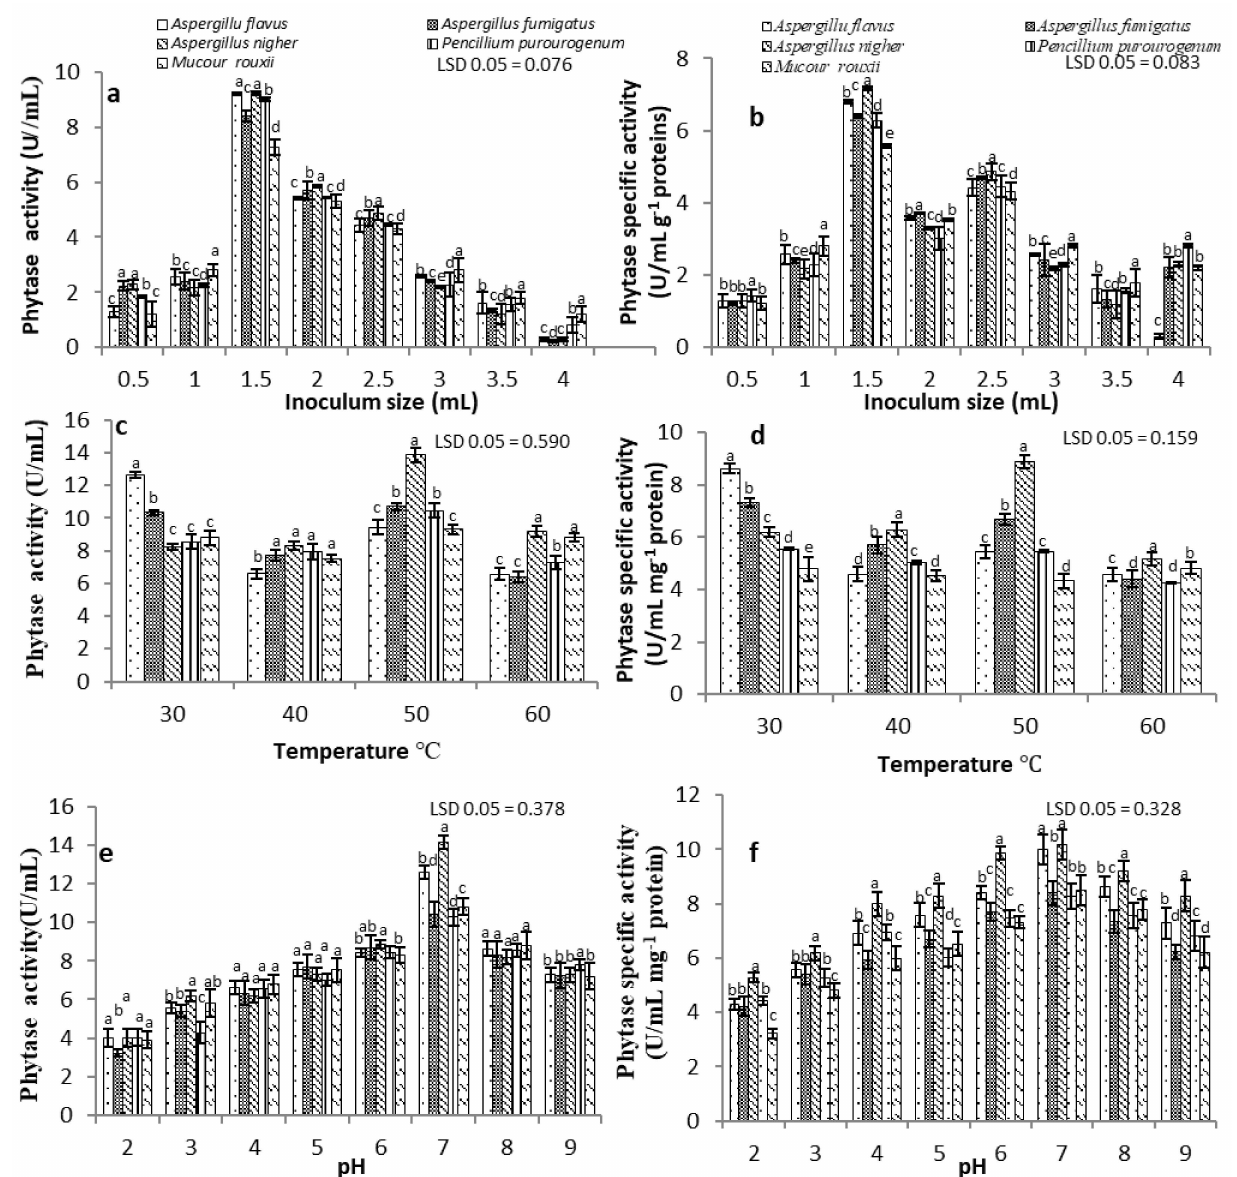
Figure 3. Effect of various eco-cultural conditions (inoculum size, temperature, and pH) on phytase activity ( a , c , e ) and phytase specific activity ( b , d , f ) from selected fungi ( Aspergillus niger , Aspergillus flavus , Aspergillus fumigatus , Penicillium purourogenum , and Mucor rouxii ) having higher inherent phytase production potential. The given LSD value at 0.05 level refers to the significant differences among mean values of each treatment.